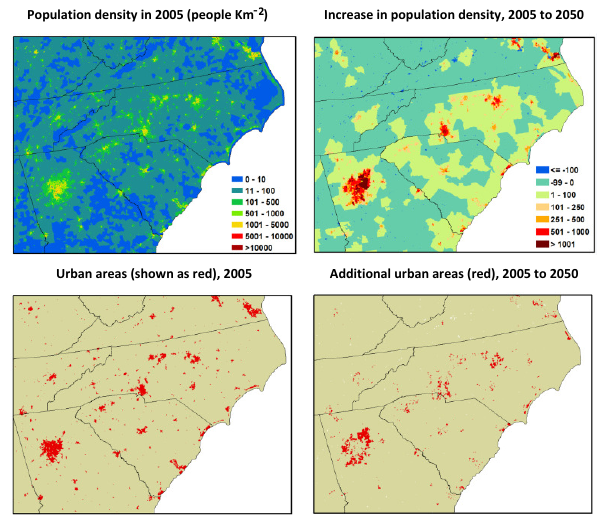
Figure 6. ICLUS population density and urban shapefiles for 2005 are shown on the left. Difference plots indicating ICLUS-predicted changes to these metrics from 2005 to 2050 are shown to the